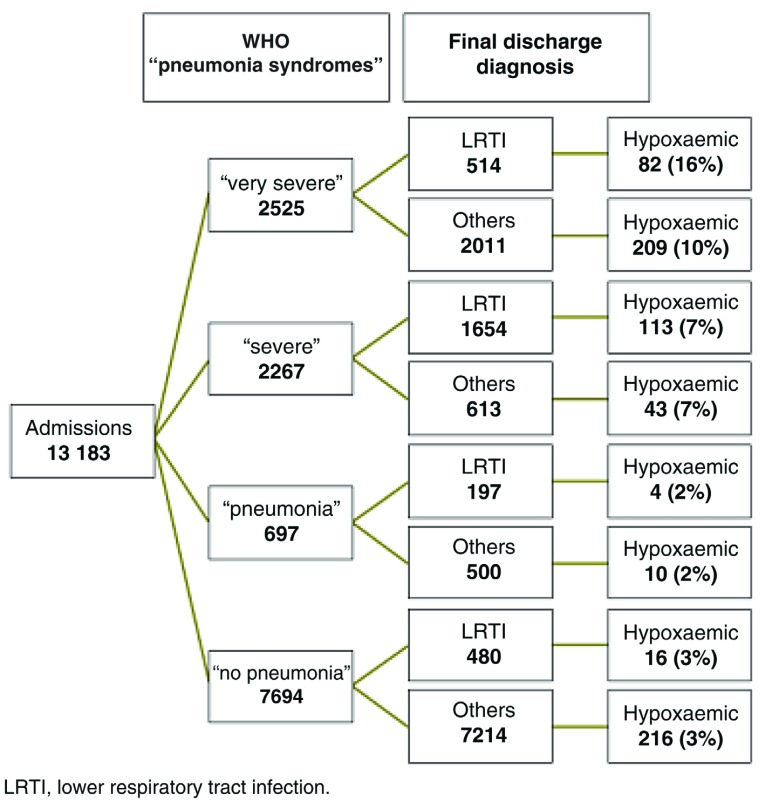
Lower respiratory tract infections and other non-respiratory diagnoses in 13,183 Kenyan children admitted to hospital (from Mwaniki
et al. 2009;
5).